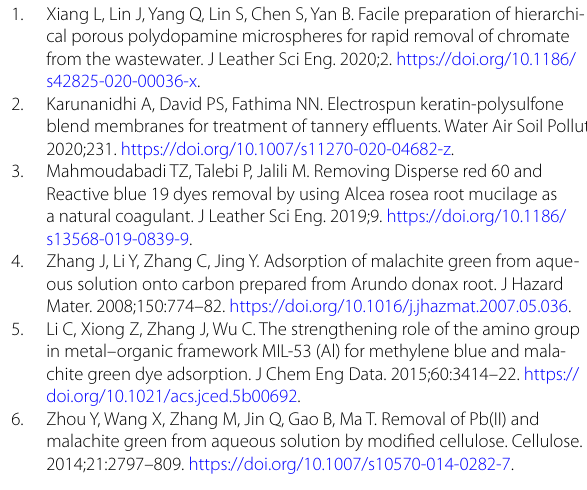
cycles. Table S1. The parameters of kinetics for adsorption of MG onto ZIF- 67/cotton fibers. Table S2. The fitting results of isotherms for adsorption of MG onto ZIF-67/cotton fibers. Table S3. Range of inhibition zones of ZIF-67/cotton against E. coli and S. aureus . Acknowledgements The authors would like to thank the Analytical & Testing Center of Sichuan University for XPS and SEM measurements. We also thank Dr. Sha Deng and Hongyan Xiao for experimental